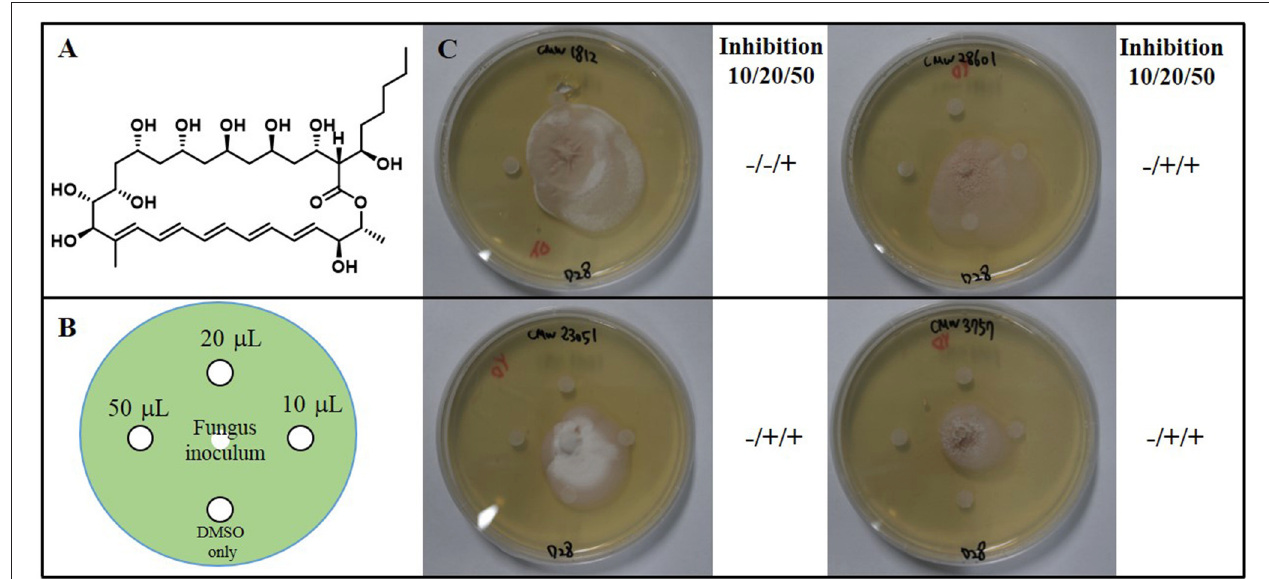
FIGURE 5 | (A) The chemical structure of fungichromin. (B) Petri plate antifungal activity assay, showing the placement of three concentrations (10 µ L, 20 µ L, 50 µ L) of fungichromin (10 mg/mL) dissolved in DMSO, the control (DMSO only, 10 µ L) , and the placement of the fungal inoculum. (C) Representative image examples of